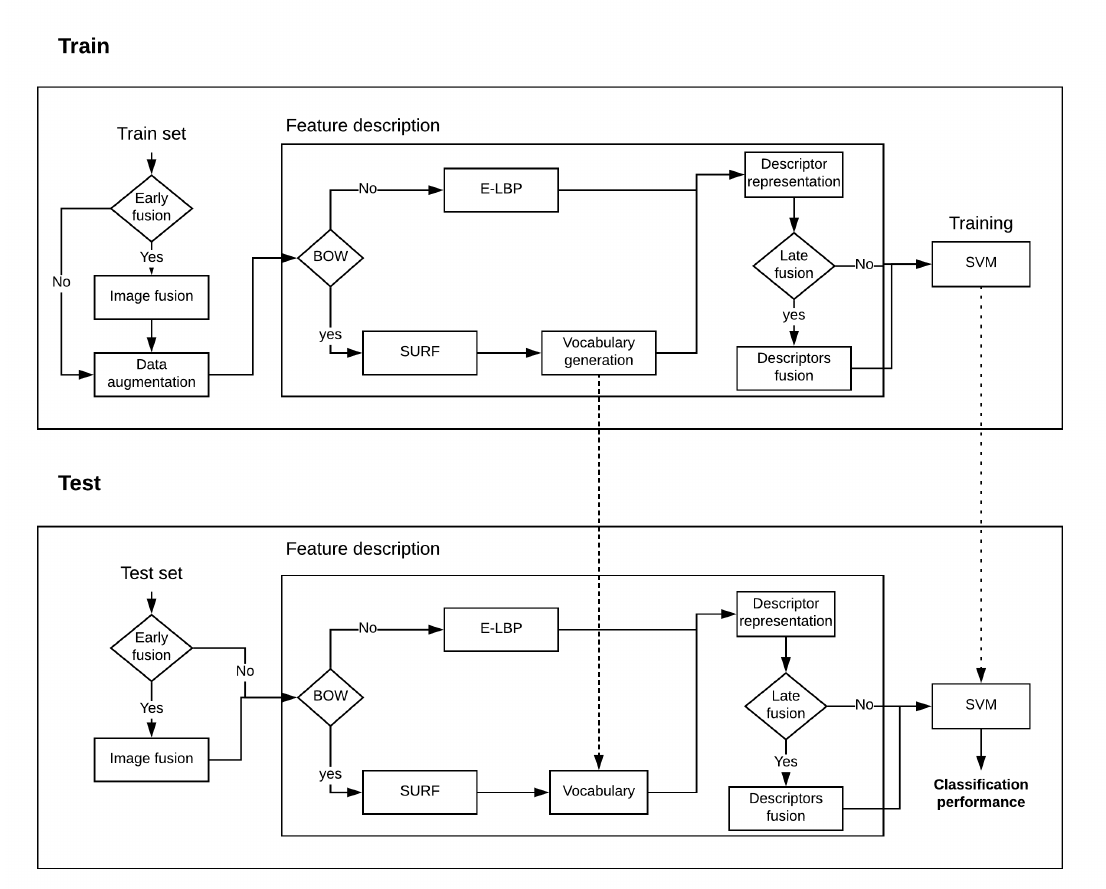
Figure 5. Block diagram of training and testing